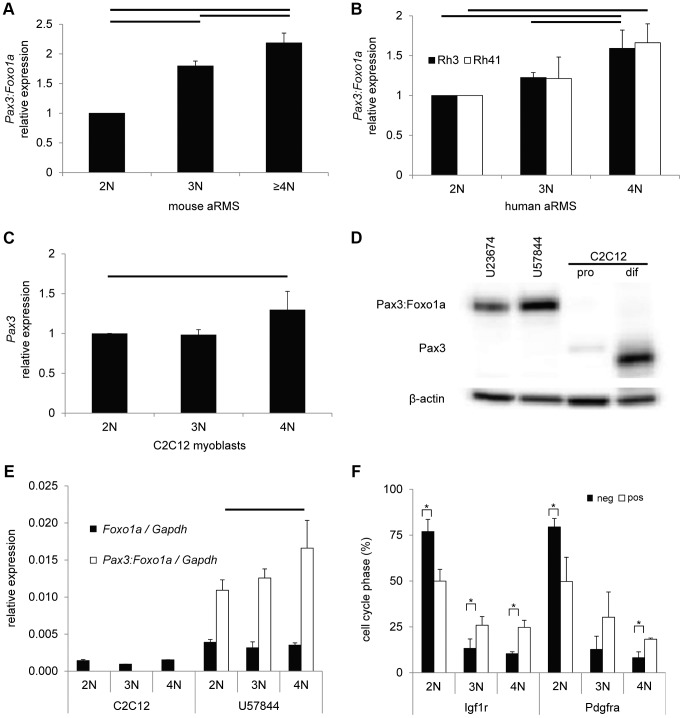
Pax3:Foxo1a activity is cell cycle dependent.(A) mRNA expression of Pax3:Foxo1a normalized by Gapdh in U23674 mouse aRMS primary cell culture sorted by DNA content. Black lines show significant differences (p<0.05). (B) mRNA expression of PAX3:FOXO1A normalized by GAPDH in Rh3 and Rh41 human aRMS cell lines sorted by DNA content. (C) mRNA expression of Pax3 normalized by Gapdh in C2C12 murine myoblasts sorted by DNA content. (D) Western blot analysis of Pax3 and Pax3:Foxo1a in unsorted murine U23674 aRMS cells (genotype Pax3 (Pax3:Foxo1a activated/Pax3:Foxo1a activated)), murine U57844 aRMS cells (genotype Pax3 (wt/Pax3:Foxo1a activated)), proliferative C2C12 myoblasts (pro) and differentiating C2C12 myoblasts (dif). (E) mRNA expression of Foxo1 and Pax3:Foxo1a normalized to Gapdh in C2C12 myoblasts and the U57844 mouse aRMS primary cell culture. (F) Cell cycle analysis after sorting for Pax3:Foxo1a targets Igf1r or Pdgfra in mouse aRMS tumor cells. Nearly twice as many 4N cells are Igf1r (or Pdgfra) positive versus Igf1r (or Pdgfra negative), suggesting these Pax3:Foxo1a targets may have a functional role late in the cell cycle (* P<0.05). pos, positive. Neg, negative.